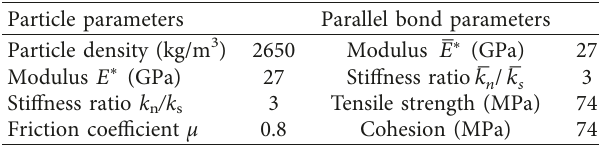
Figure 10: Results of uniaxial compression tests of intact rock. Table 3: Microscopic parameters of balls and bonds in intact rock.